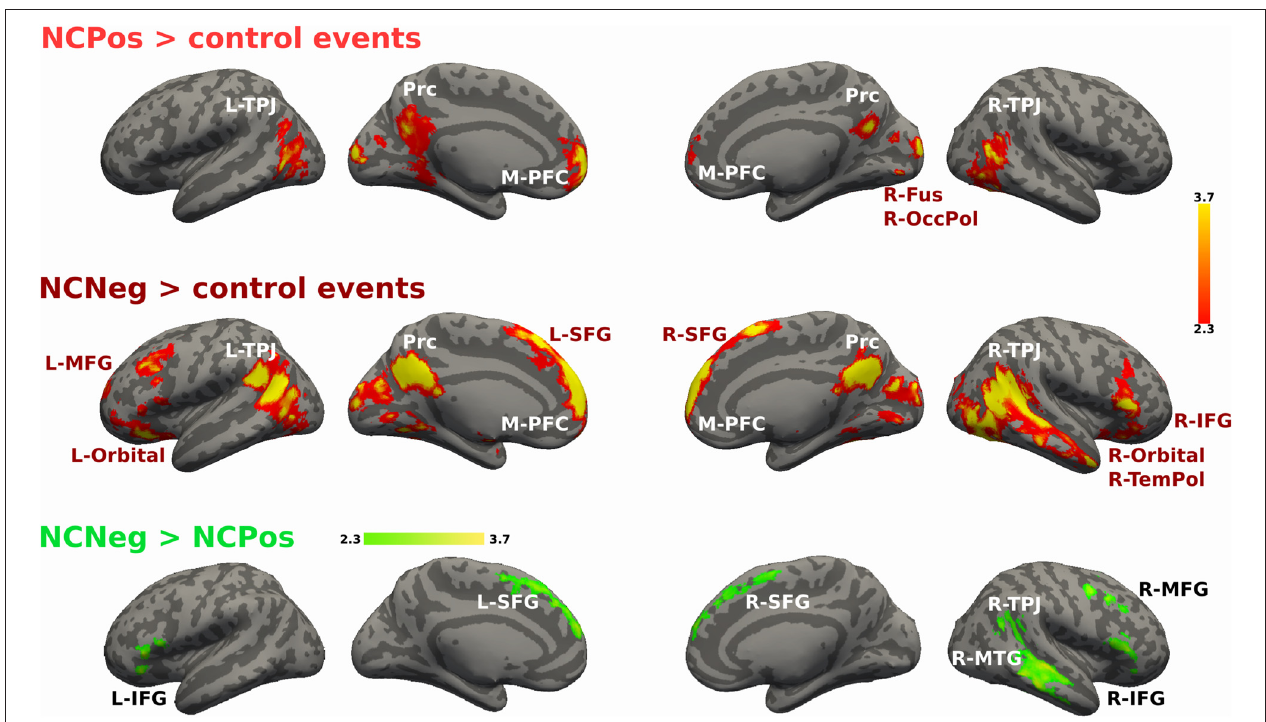
FIGURE 7 | Activations maps for non-cooperative confederate. A whole-brain contrast for non-cooperative confederate in positive situations with respect to control events (NCPos > control events) revealed increased activity in bilateral TPJ, Prc, M-PFC and visual areas; right fusiform cortex and occipital pole. Additionally, contrast for non-cooperative confederate in negative situations with respect to control events (NCNeg > control events), includes increased activity in right temporal pole (R-TemPol), bilateral orbitofrontal cortex (Orbital), L-MFG, and bilateral superior frontal gyrus (SFG), and right IFG (R-IFG). Color bar indicates z